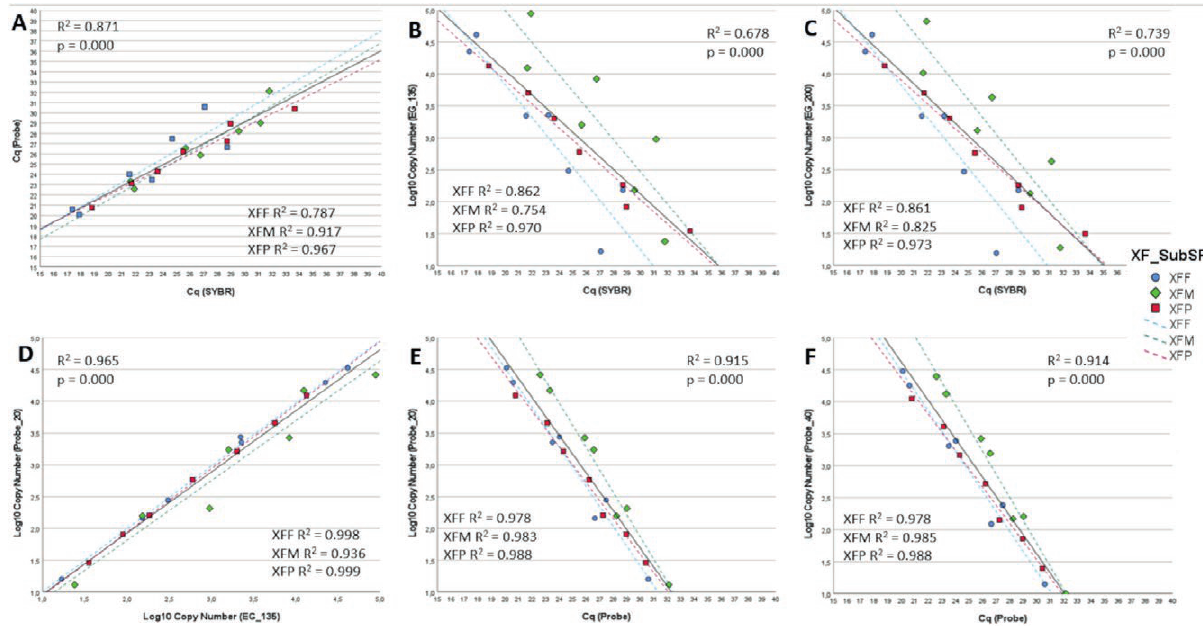
Figure 3. Scatterplots showing the correlations between results obtained by different diagnostic assays in the following pairs: (A) qPCR with SYBR Green on the X-axis and qPCR with Probe on the Y-axis; (B) qPCR with SYBR Green on the X-axis and dPCR with EG, threshold set at 135 RFU, on the Y-axis; (C) qPCR with SYBR Green on the X-axis and dPCR with EG, threshold set at 200 RFU, on the Y-axis; (D) dPCR with EG, threshold set at 135 RFU, on the X-axis and dPCR with Probe, threshold set at 20 RFU, on the Y-axis; (E) qPCR with Probe on the X-axis and dPCR with Probe, threshold set at 20 RFU, on the Y-axis; and (F) qPCR with Probe on the X-axis and dPCR with Probe, thresh- old set at 40 RFU, on the Y-axis. Markers on the plots indicate single samples, and their colours and shapes indicate the subspecies of Xylella fastidiosa they belong to, as reported in the legend. Each graph contains three dashed trendlines, which are calculated on samples belonging to a single subspecies, and a solid-line trendline, calculated on all the samples for each combination of the diagnostic assays. Each graph also reports the overall R 2 value and the P value obtained from linear regression analysis, as well as the R 2 value for each X. fastidiosa